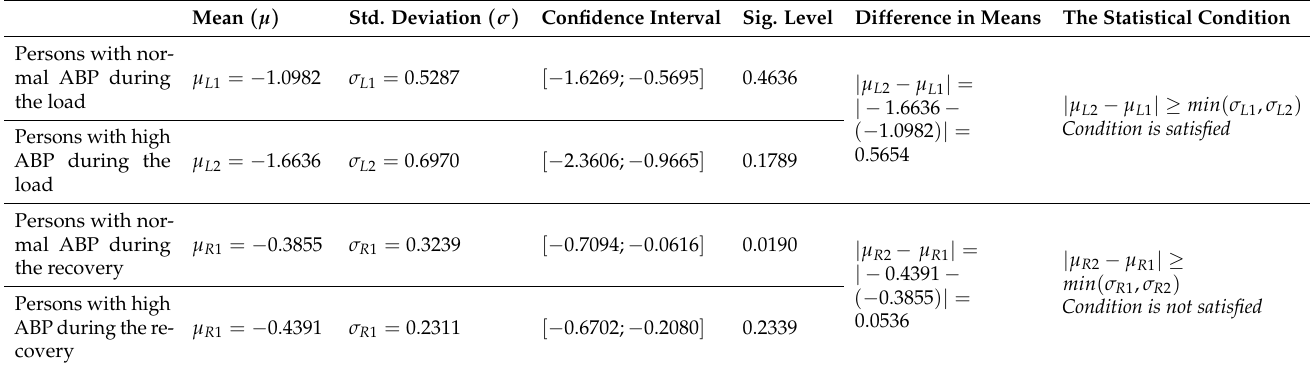
Table 3. Mean, standard deviation and significance values for the cohort of persons throughout the load and recovery process during the bicycle stress test.